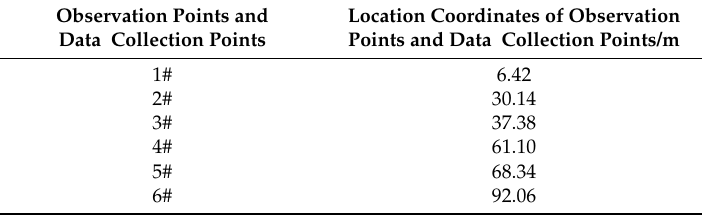
Table 1. The coordinates of the various observation points and data collection points.